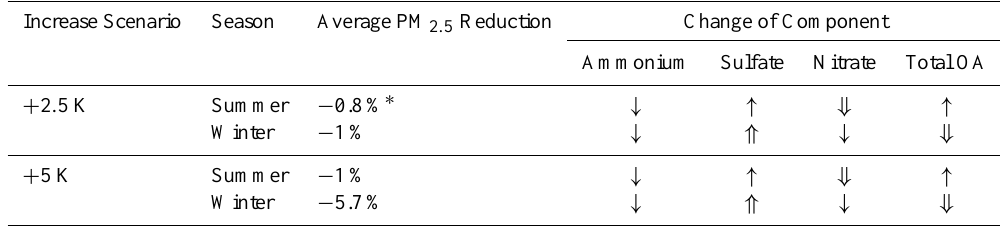
Table 3. Response of the major PM 2 . 5 components to a 2.5 and 5 K increase of temperature, and percent average predicted reduction of total PM 2 . 5 , during the modelled summer and the modelled winter